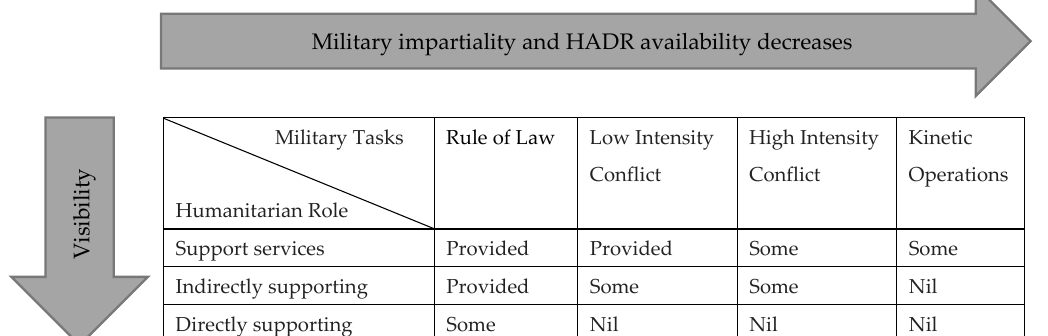
Table 2. Humanitarian assistance and disaster relief (HADR) logistical support from the military. 2019 , 6 , x FOR PEER